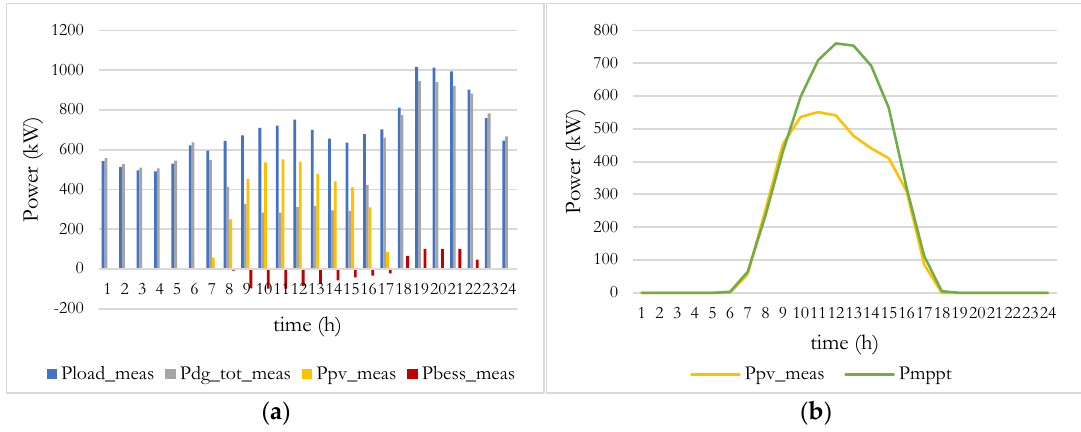
Figure 3. ( a ) Measures of the main power flows into the micro-grid case study managed by the actual control logic; ( b ) Comparison between MPPT PV power ( Pmppt ) and measured PV power ( Ppv_meas ).